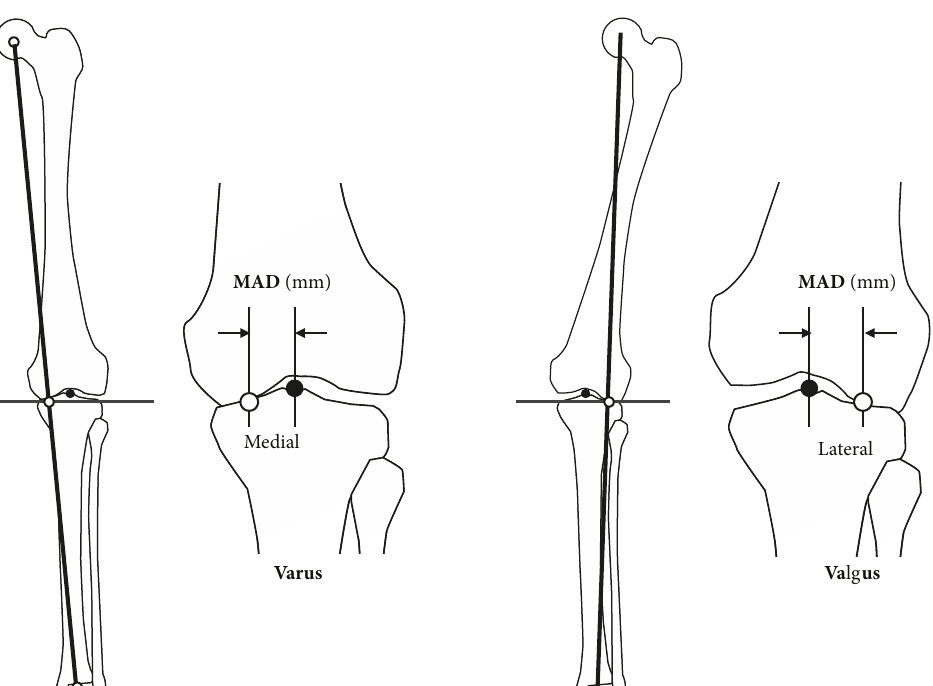
Figure 2: Mechanical axis deviation (MAD) is the perpendicular distance between the mechanical axis of the lower extremity and the center of the knee